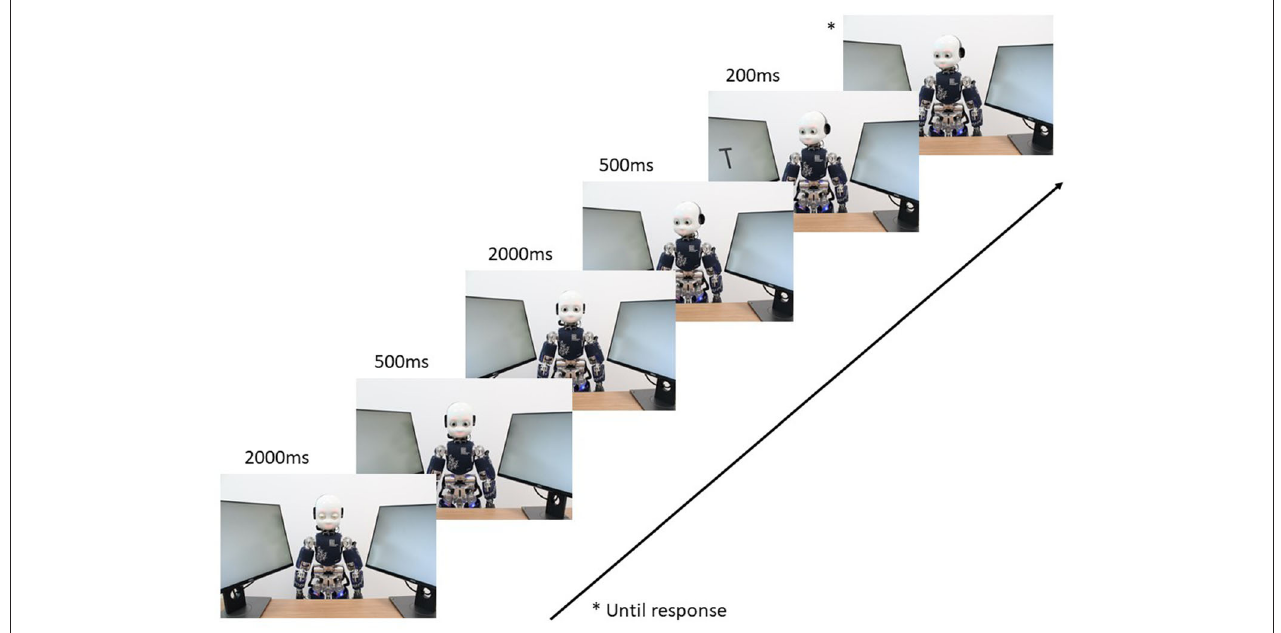
FIGURE 1 | Trial sequence of the gaze-cueing paradigm: Each trial started with iCub’s eyes closed. iCub would then open its eyes and fixate on the observer’s eyes to engage in mutual gaze. Next, iCub would make a gaze shift to either the right or left. Next, a target appeared for 200ms. If the target appeared in the same direction of the cue, the trial was considered valid. Targets appeared in the opposite direction of the cue for invalid trials. The stimulus onset asynchrony (SOA) was set to